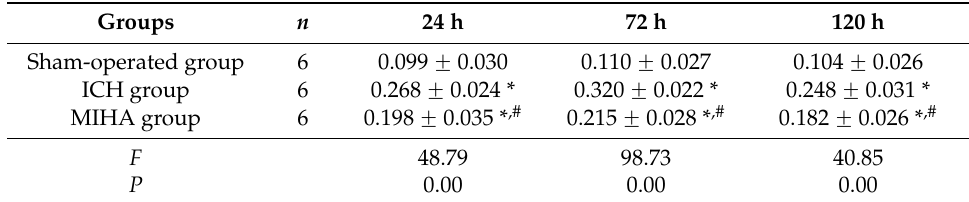
Table 4. The positive cell indexs (PCIs) of phospho-c-Jun NH 2 -terminal kinase (pJNK) in different groups at each time point ( x ± s).